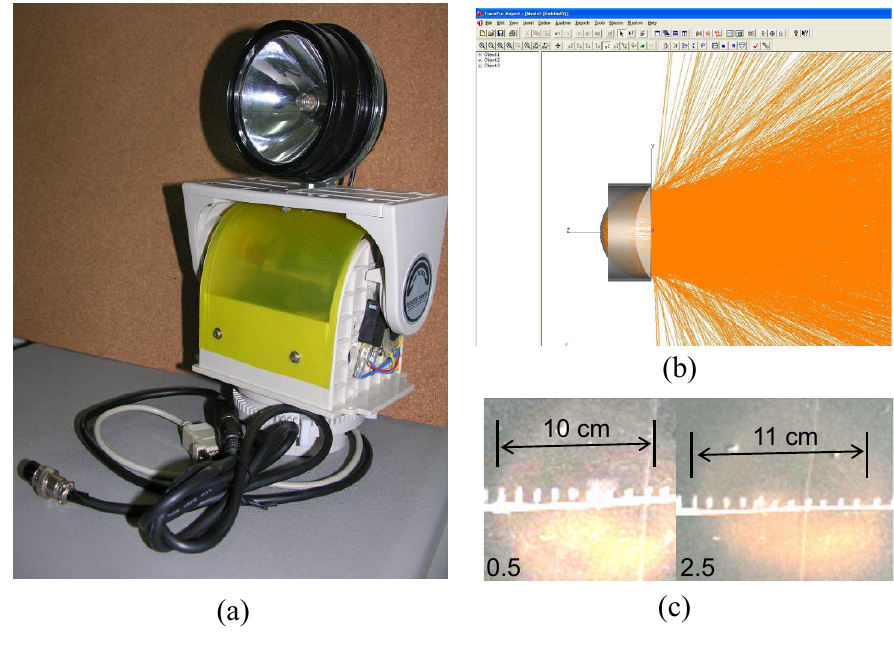
Figure 4. The photograph of the focusing spotlight (a) and the simulation results of the spotlight focusing design (b). The projection patterns of 0.5 meter distance and 2.5 meters away are shown in